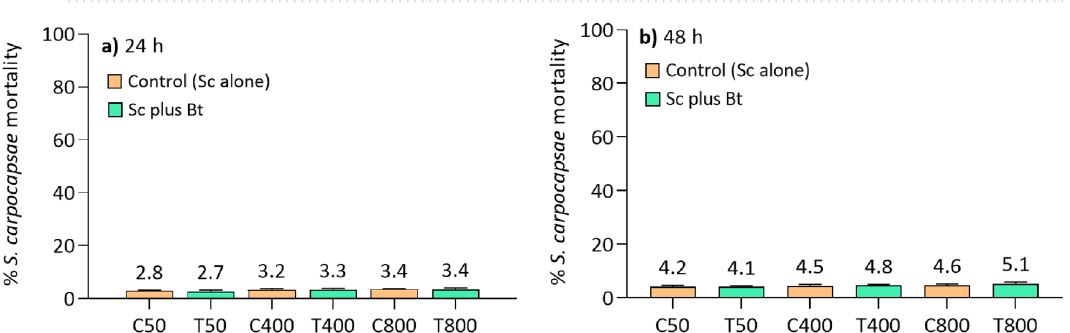
Figure 5. Evaluation of the potential adverse effects of Bt (0.564 μg/mL) on Sc (5 × 10, 4 × 10 2 and 8 × 10 2 IJs) viability at 24 h ( a ) and 48 h ( b ). The mortality of Sc in all assays did not exceed about 3% (24 h) and 5% (48 h) and was comparable to the controls with Sc alone. These assays were carried out before the combined administration of the two bio-insecticides. C: control, Sc alone; T: treatment, Sc plus